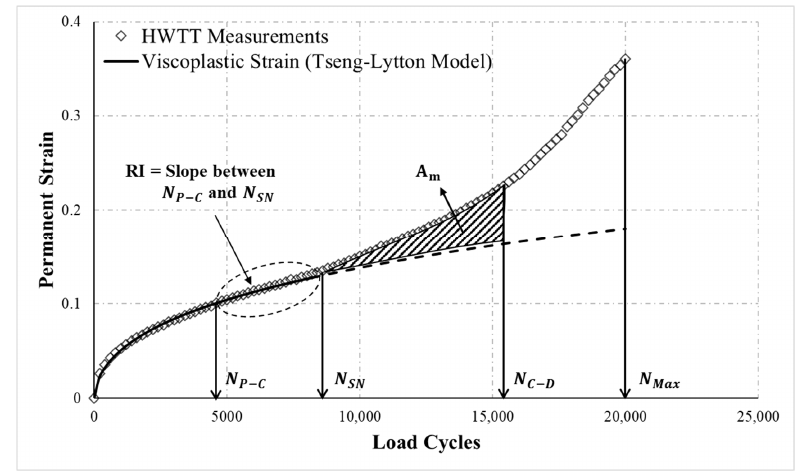
Figure 4. A schematic of RI and D (cid:2923) in the HWTT.